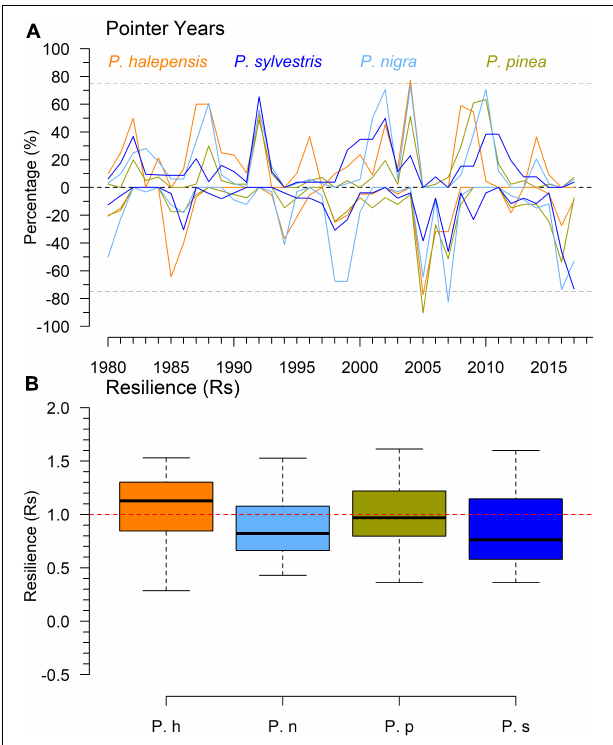
FIGURE 5 | Presence of pointer years and resilience to the 2005–2007 drought period. The percentage of trees of each species (A) showing abrupt growth enhancements and reductions during the 1980–2017 period and the resilience to the 2005–2007 drought period (B) is shown for each pine species. In plot (A) dashed lines indicate the 75% thresholds. Species’ codes: Ph, P. halepensis ; Pn, P. nigra ; Pp, P. pinea ; Ps, P. sylvestris .